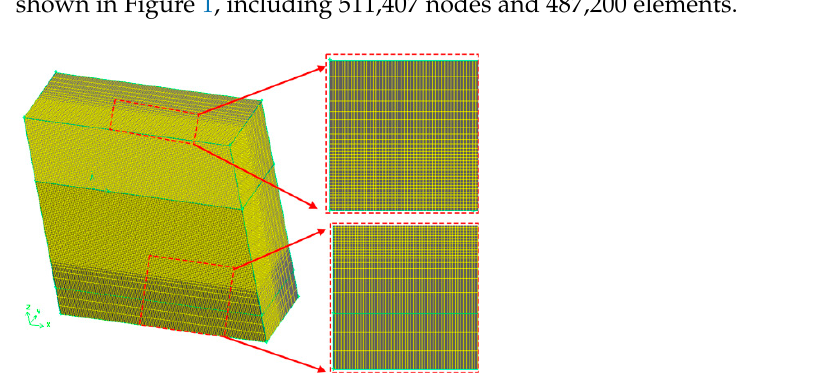
Figure 1. Calculation meshes of the numerical simulation in laser deep penetration welding.